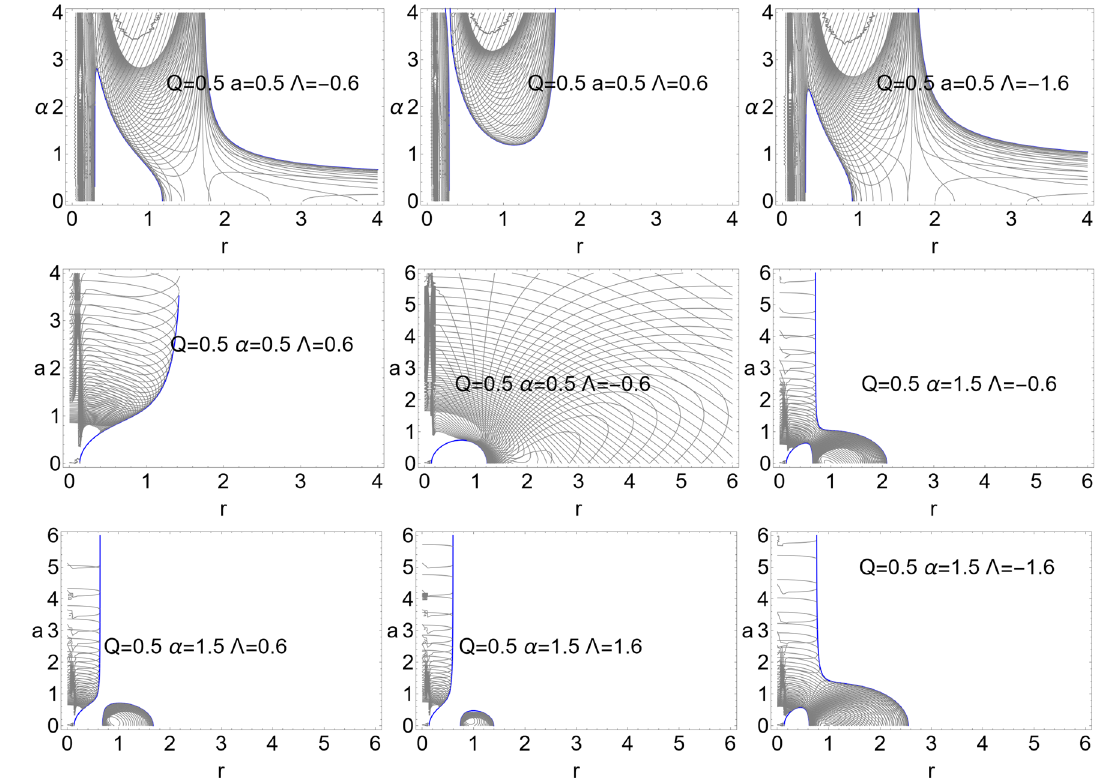
Fig. 10 Accelerating charged spinning BH with cosmological con- stant of Eq. (29). Metric bundles on the equatorial plane are shown in the plane a − r , where a is the spin parameter ( M = 1), for differ-